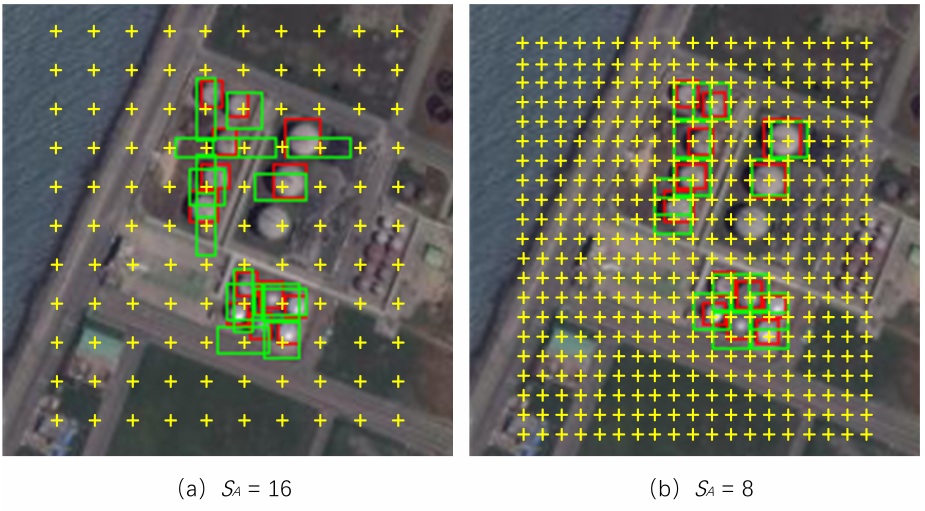
Figure 1. Anchor sampling in different S A . S A mean the stride of the anchors in different detection framework. The green bounding box represents the anchor, the red represents ground-truth.